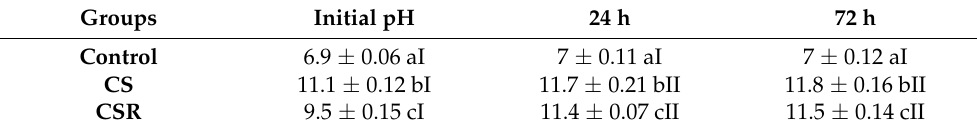
Table 1. pH values.